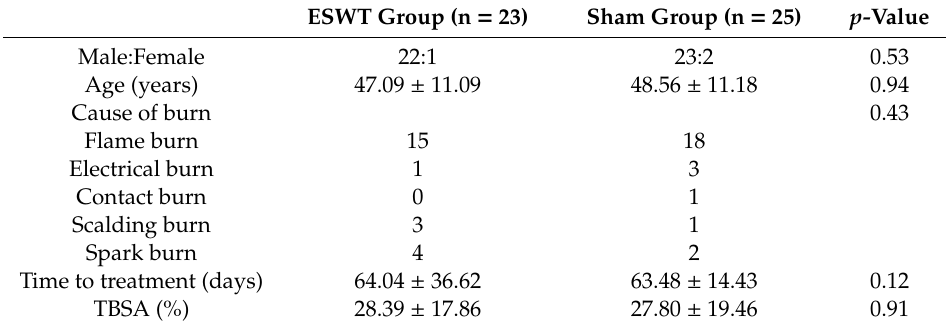
Table 1. Baseline characteristics of the study